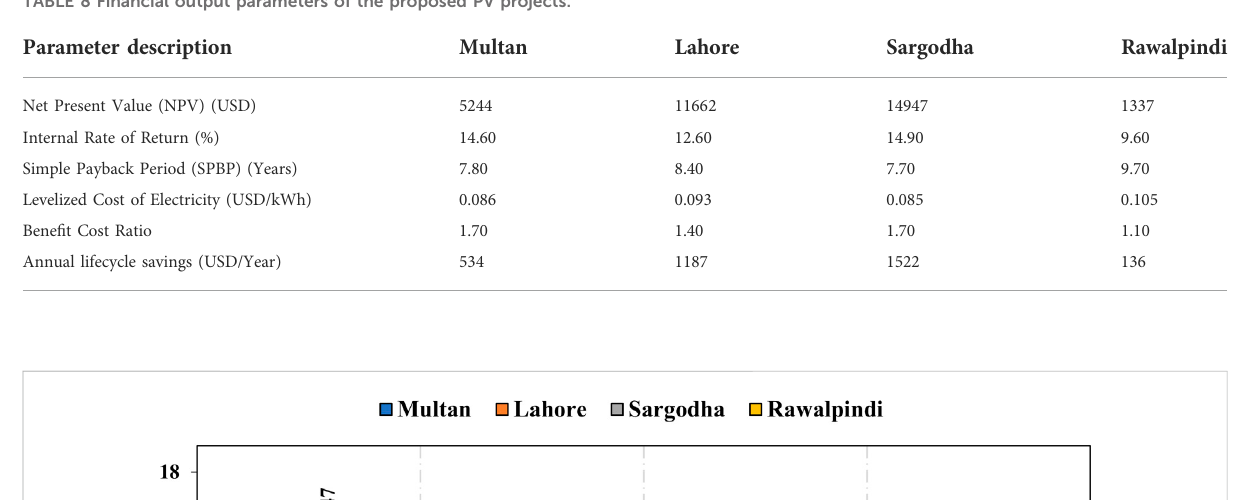
TABLE 8 Financial output parameters of the proposed PV projects.